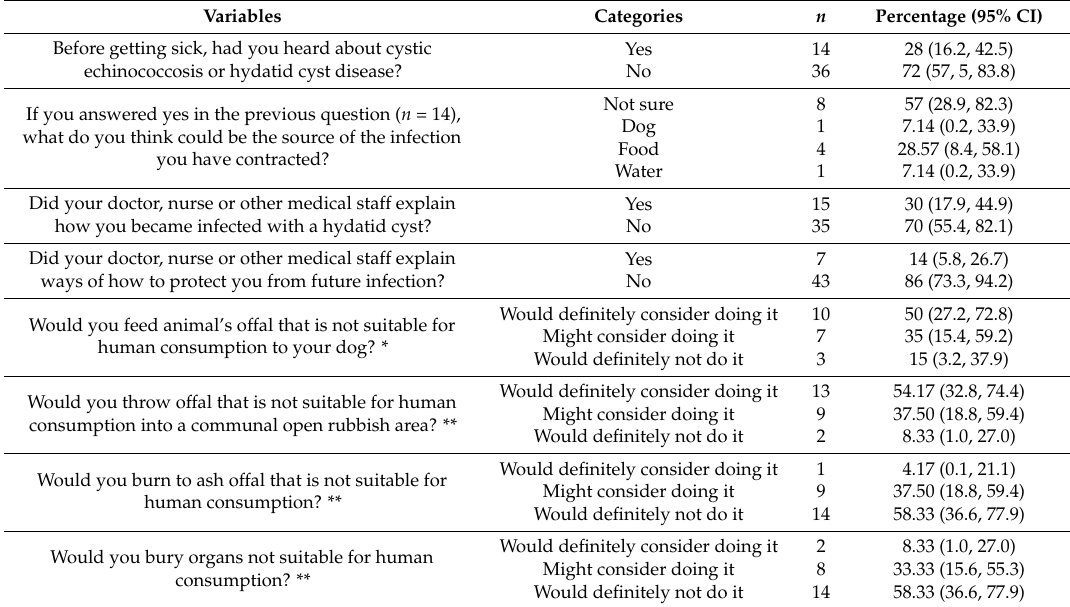
Table 4. Descriptive self-reported knowledge and attitudes toward cystic